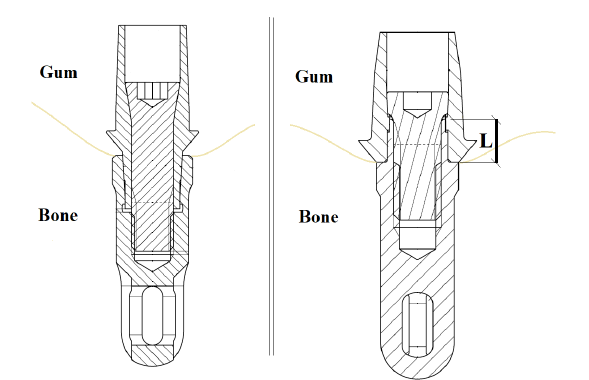
Figure 1. Comparison of placement of the 2 anal- ysed dental implant variants inside the bone. Left – the internal hexagon variant (subgingival placement) and right – the external hexagon variant (transgingi- val placemenent). The lenght L indicates the portion of the intraosseous part that exceeds the bone after